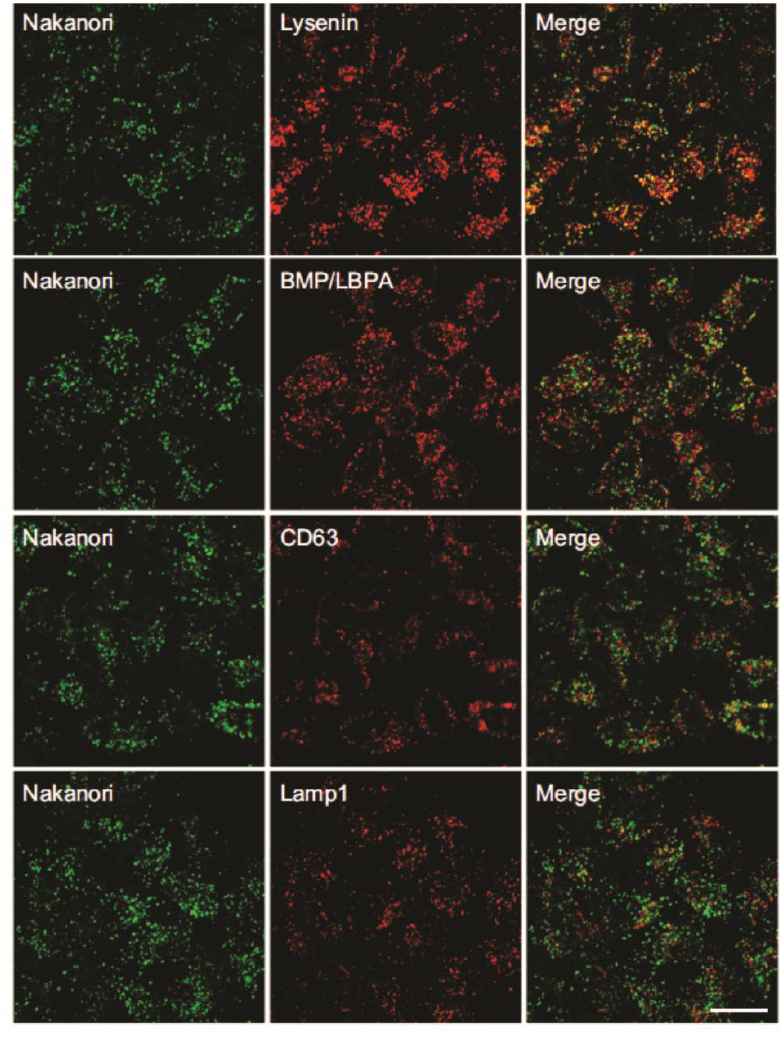
Figure 4. Intracellular distribution of nakanori and organelle markers. Representative fluorescent images of double immunolabeling of Hela cells with nakanori (green) and organelle markers (red) showing co-localization of nakanori with lysenin, and with markers of the internal membranes of late endosomes, BMP/LBPA ( bis (monoacylglycero)phosphate/lysobisphosphatidic acid) and CD63. Some co-localization of nakanori was seen with Lamp 1, as a marker of the limiting membrane of late endosomes. Scale bar: 20 m. Adapted from [40].